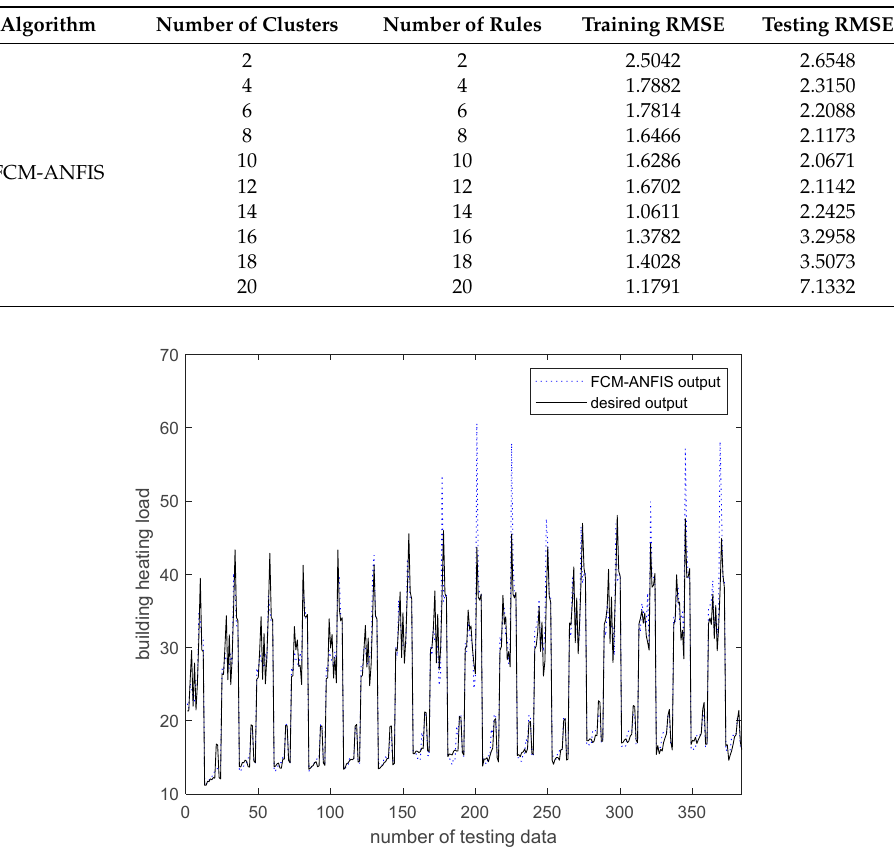
Figure 7. Comparison of the predicted and actual output values of FCM clustering-based ANFIS. Table 3. Results from ANFIS prediction experiment on the incremental tree structure based on CFCM